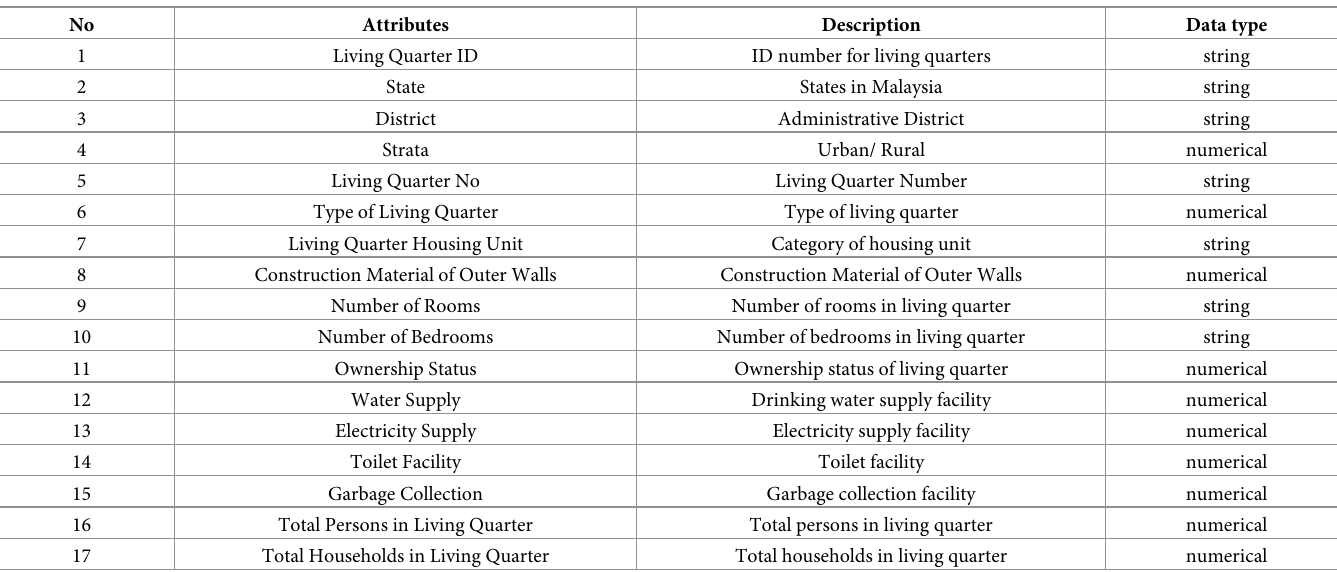
Table 4. A set of attributes from living quarters source file.